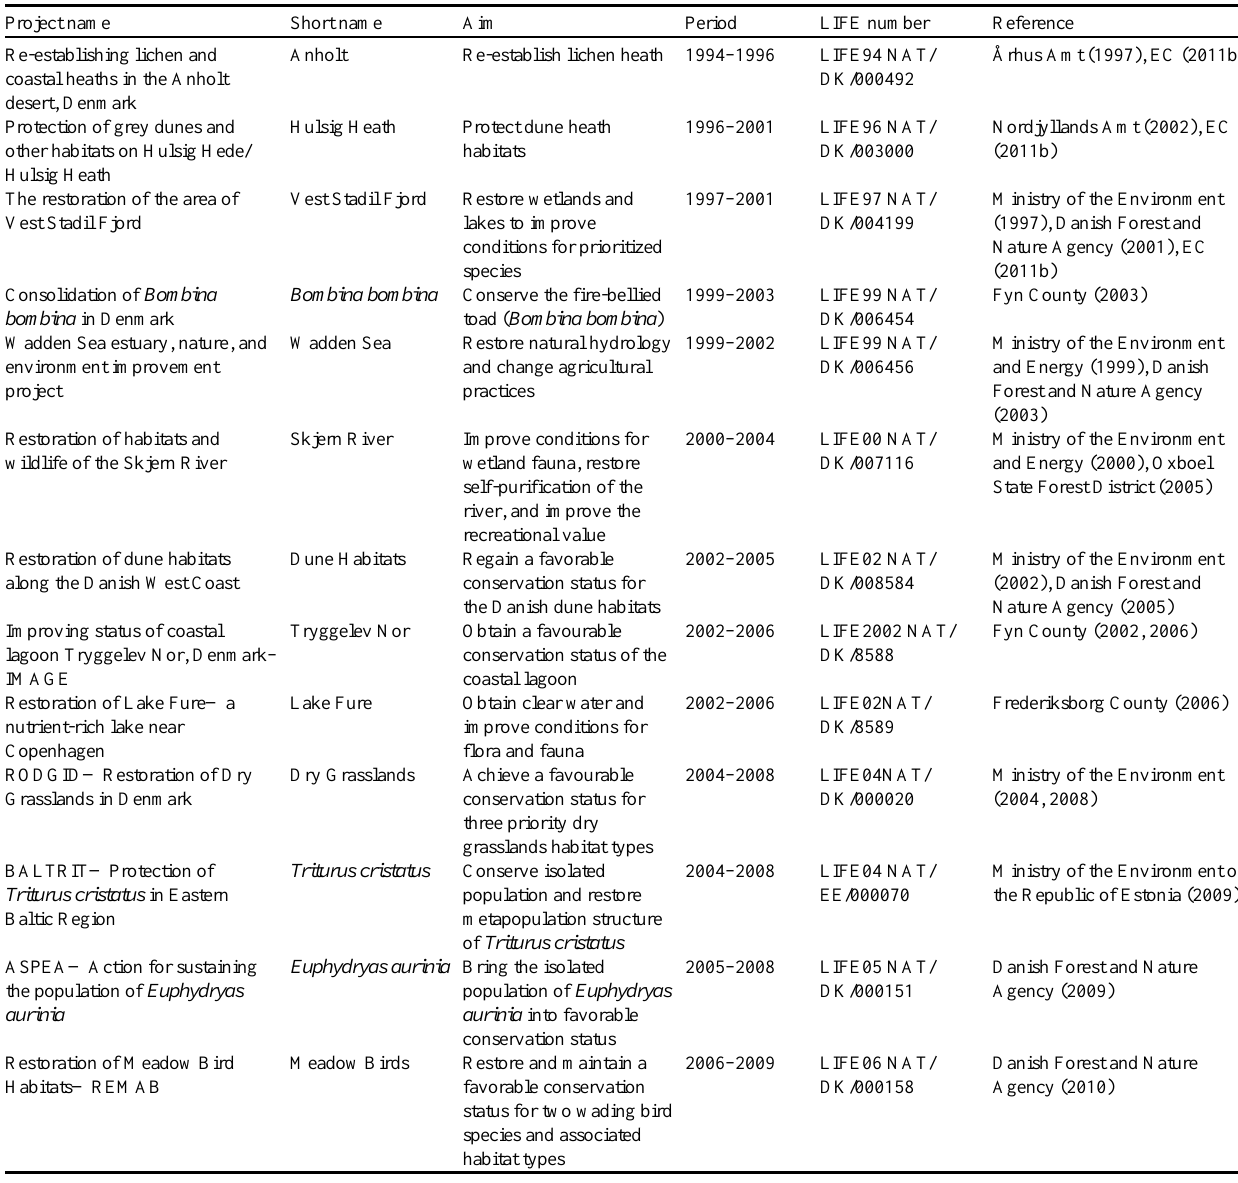
Table 1 . List of the 13 included projects, in chronological